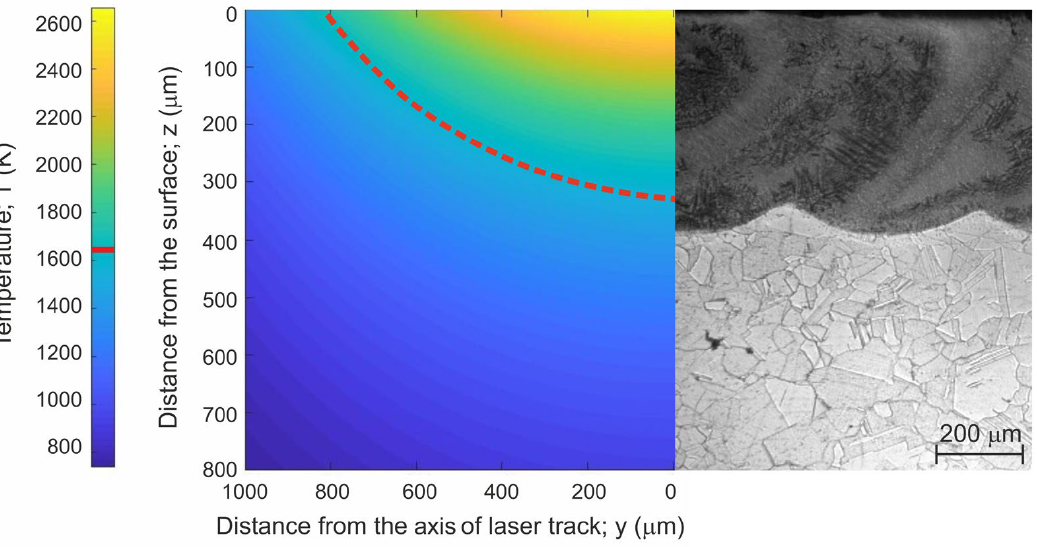
Figure 9. A 2D cross-section of the temperature distribution in the molten pool with marked melting point of Nimonic 80A alloy and the OM microstructure of laser borided layer produced at the laser beam power of 1.3 kW.